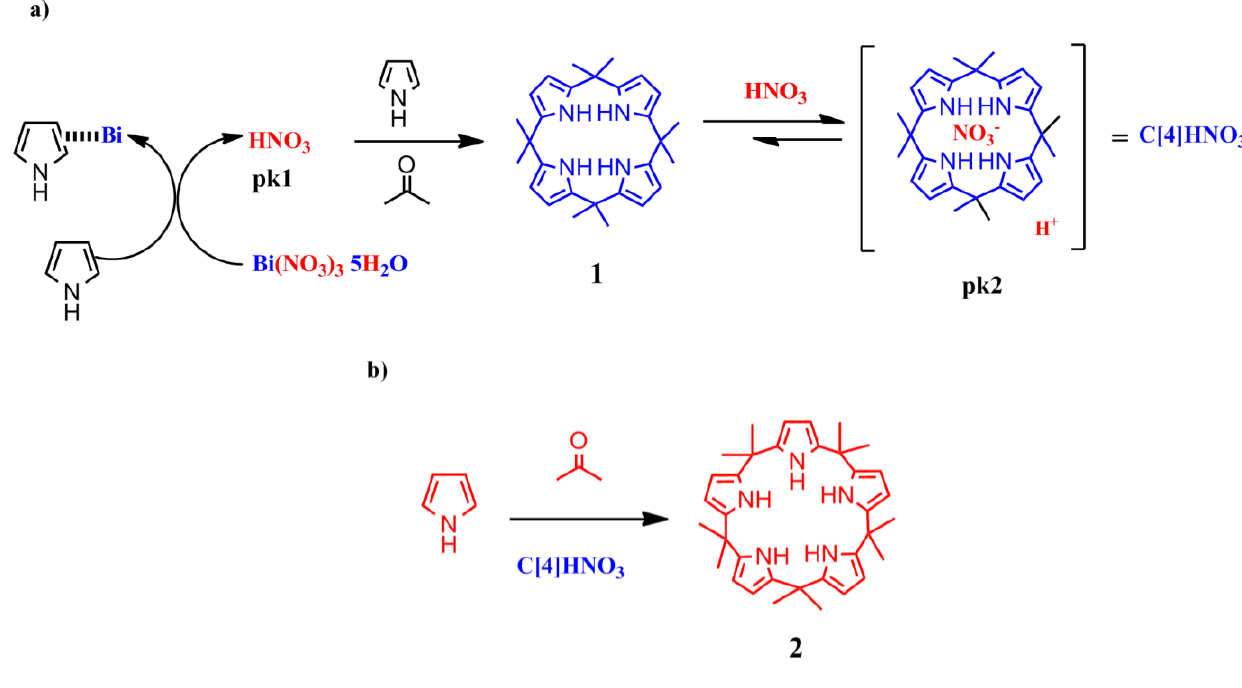
Scheme 5. Proposed mechanism for the formation of calix[5]pyrrole using Bi as